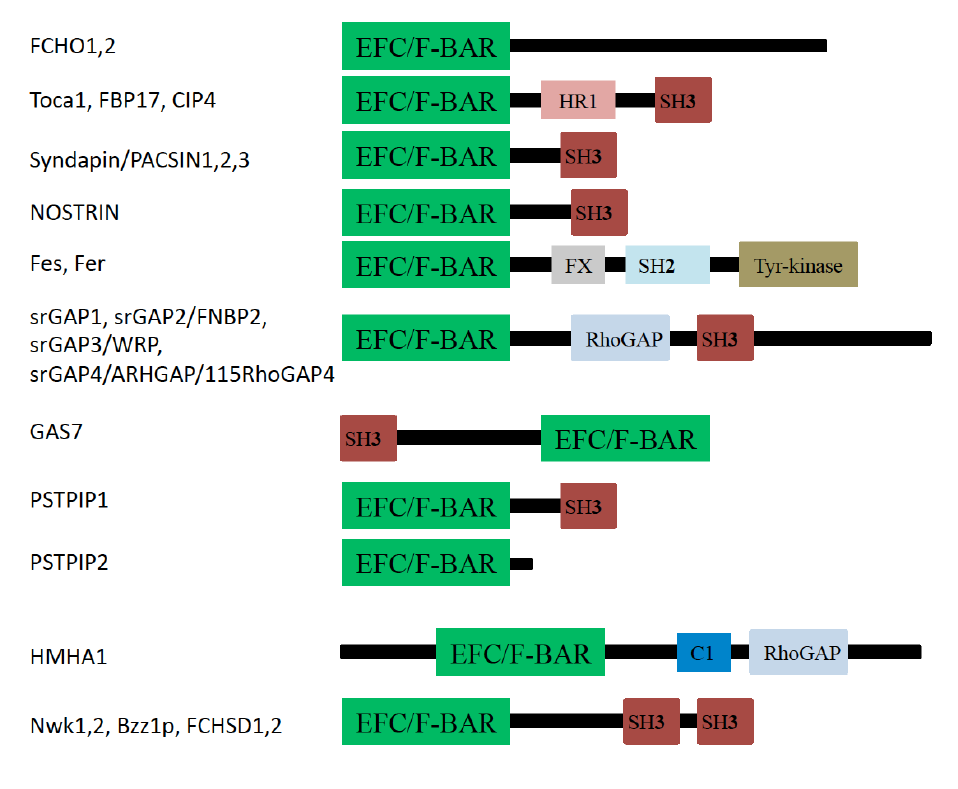
Figure 4. Domain organization of F-BAR proteins. EFC: extended FER-CIP4 homology (EFC) or FCH and BAR (F-BAR) domain; HR1: Protein kinase C-related kinase homology region 1 domain; SH2: Src homology 2 domain; SH3: Src homology 3 domain; FX: F-BAR extension domain; Tyr-kinase: Tyrosine kinase domain; RhoGAP: Rho GTPase activating protein domain; C1: Protein kinase C conserved region